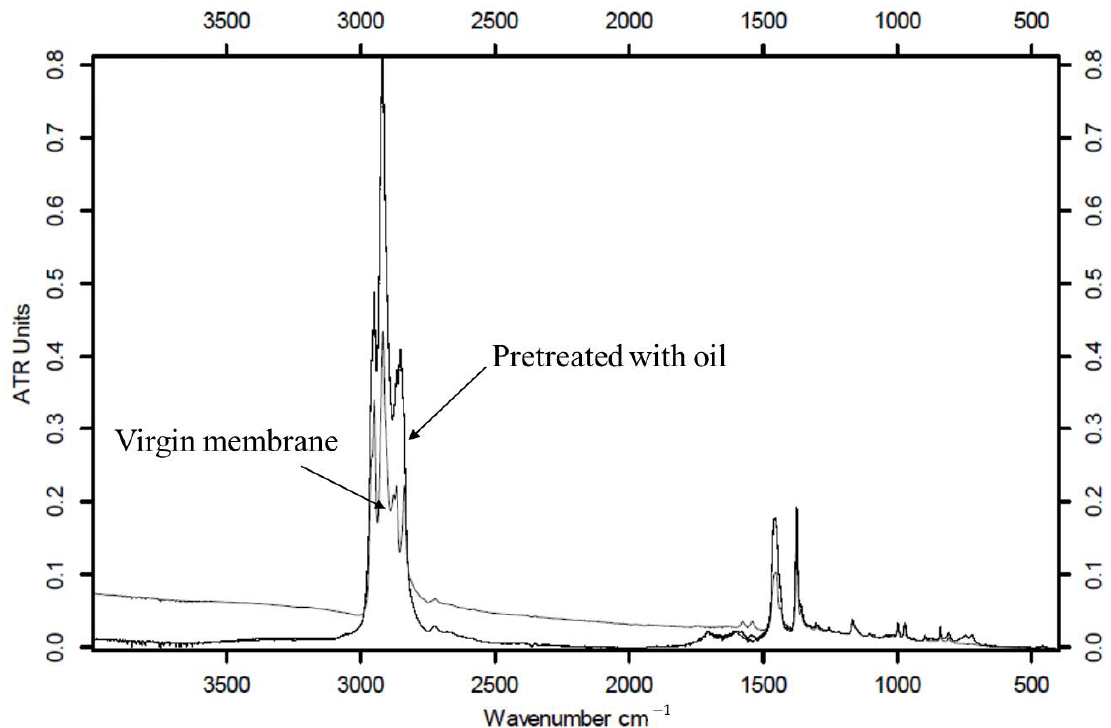
Figure A3. Image examples of emulsions in 3.5% NaCl solution ( a ) sample after 0.5 h, ( b ) sample after 2.5 h, ( c ) sample after experiment at 24 h.